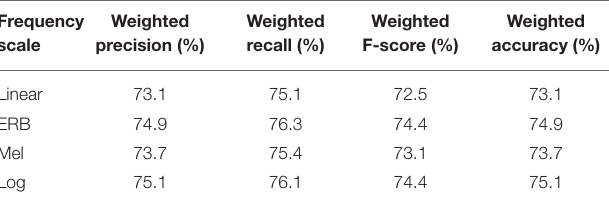
TABLE 6 | Results of Experiment 4—Combined effect of the reduced bandwidth and the µ -low companding, f s = 8kHz. Frequency